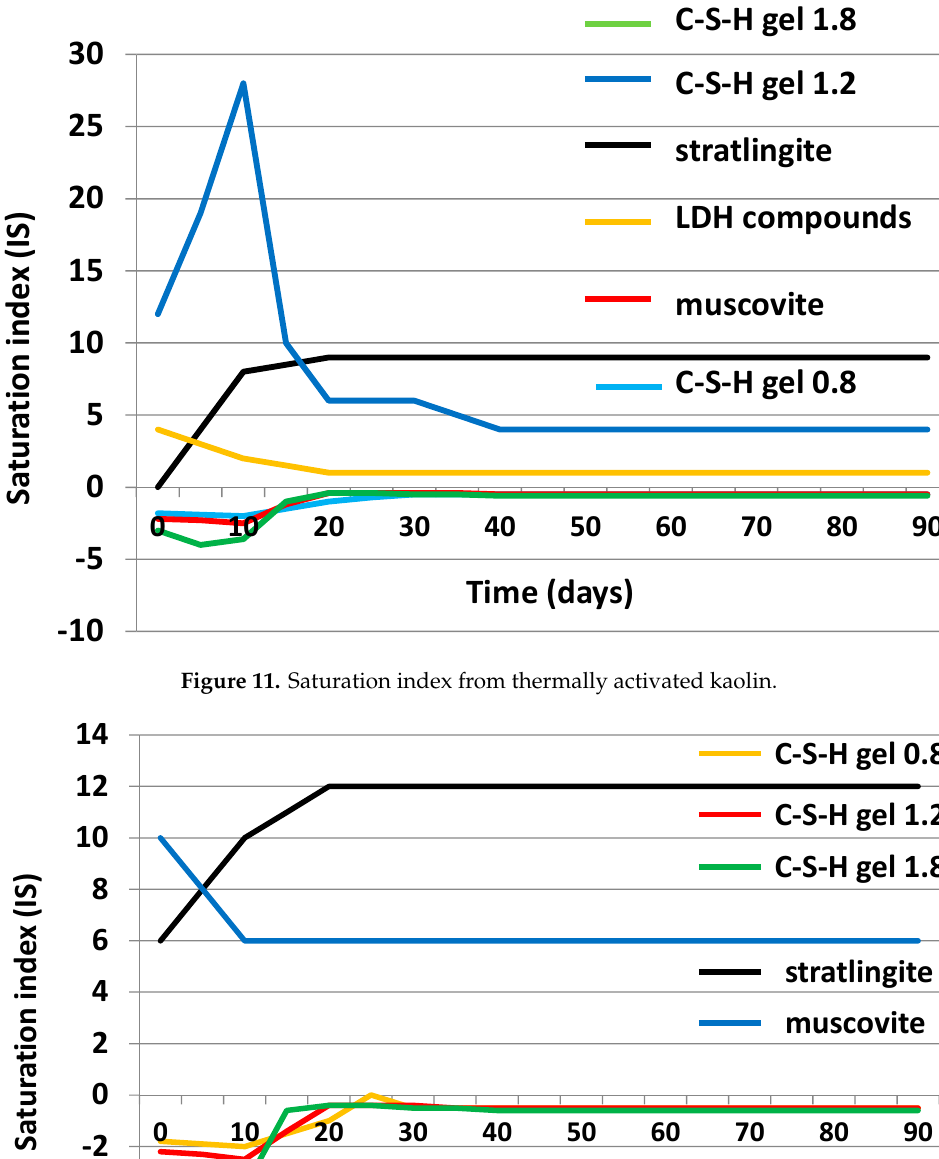
Figure 12. Saturation index from chemically and thermally activated samples.